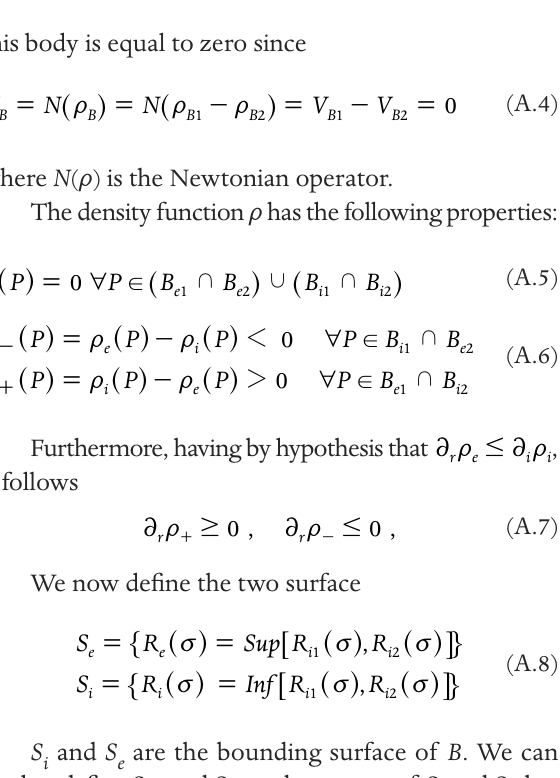
Figure A.1. The two bodies with two layers inner mass distributions and the same bounding